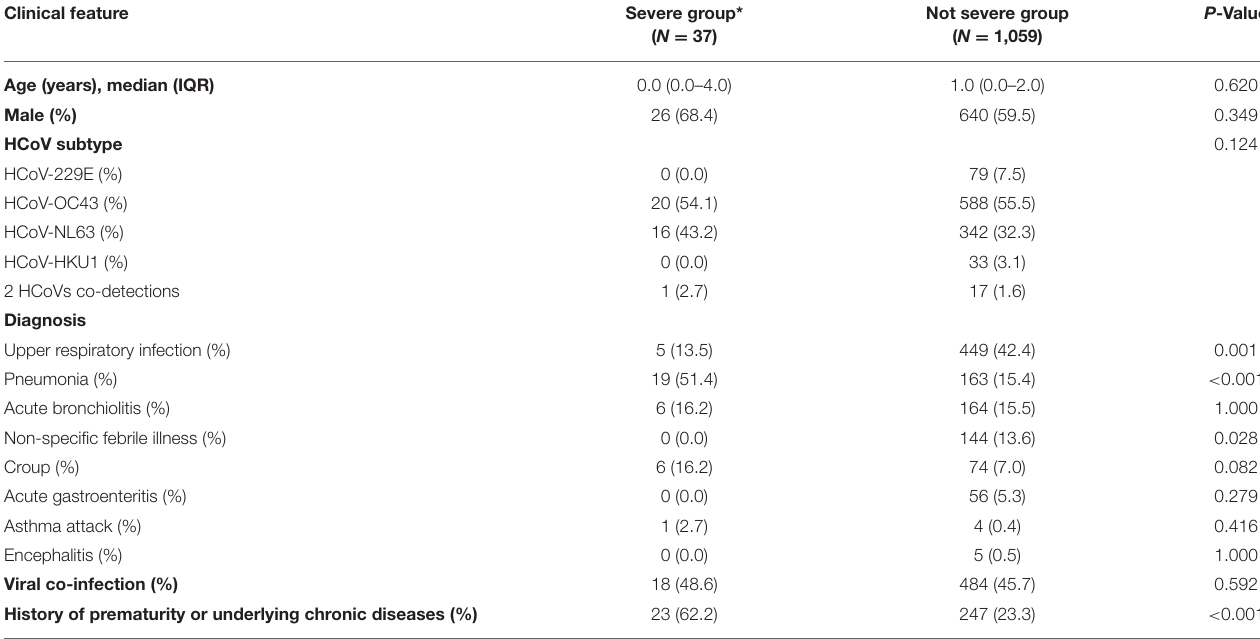
TABLE 2 | Clinical characteristics associated with HCoV infection: comparison of patients who needed high-flow nasal cannula oxygen therapy or mechanical ventilation with those who did not. Clinical